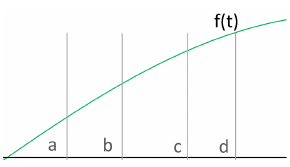
Figure 2. Monotone function f ( t )